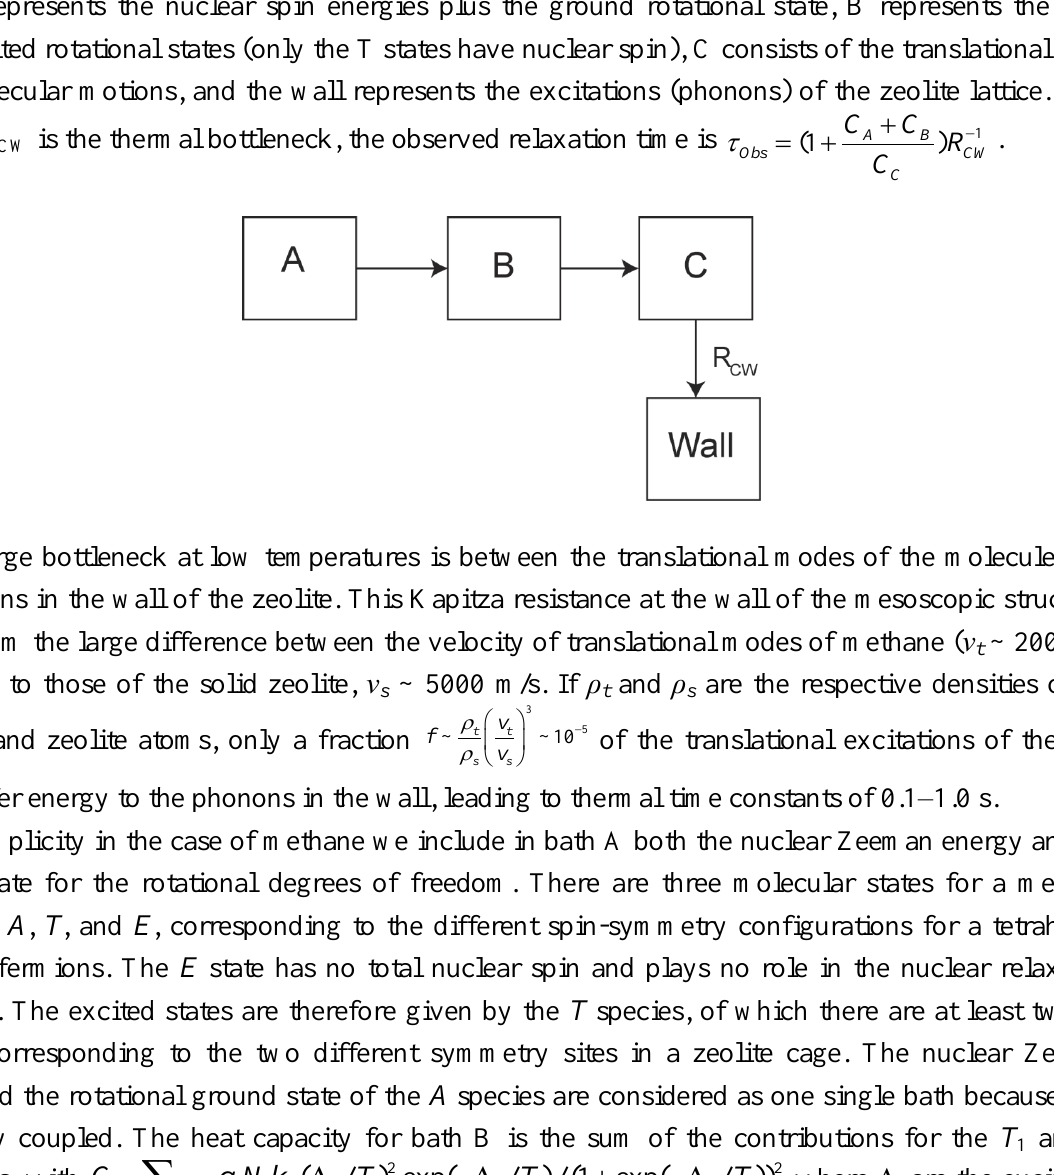
Figure 2. Multiple bath model for relaxation of methane molecules in zeolite